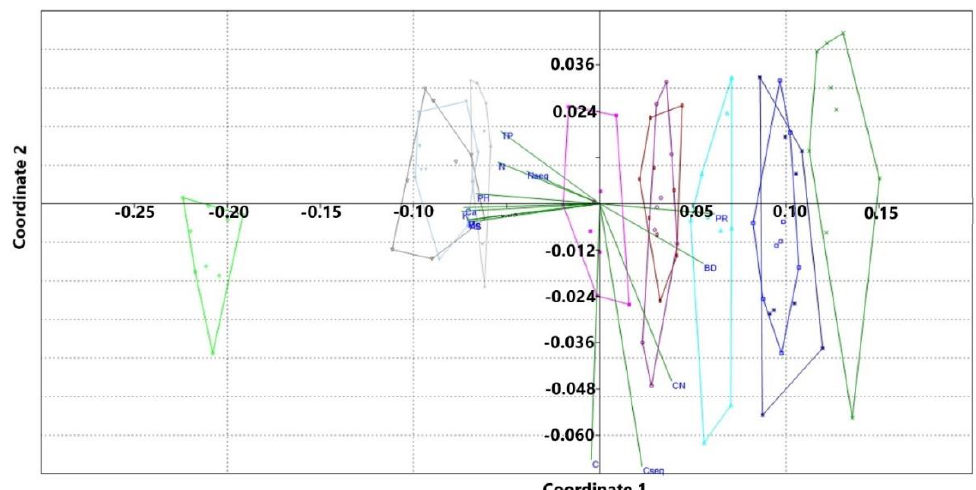
Figure 2. nMDS analysis of different soil physical properties in different mulching or no-mulching treatments for the soil layer 0–5 cm. UND, undisturbed (control), light green polygon; LM6.2, litter mulch level of 6.2 Mg ha − 1 , light grey polygon; LM12.2, litter mulch level of 12.2 Mg ha − 1 , dark grey polygon; LM18.6, litter mulch level of 18.6 Mg ha − 1 , light blue polygon; SM3.8, straw mulch level of 3.8 Mg ha − 1 , light purple polygon; SM7.6, straw mulch level of 7.6 Mg ha − 1 , dark purple polygon; SM11.4, straw mulch level of 11.4 Mg ha − 1 , red polygon; SDM11.1, sawdust mulch level of 11.1 Mg ha − 1 , bright light blue polygon; SDM22.2, sawdust mulch level of 22.2 Mg ha − 1 , blue polygon; SDM33.3, sawdust mulch level of 33.3 Mg ha − 1 , dark blue polygon; UNT, untreated treatment, dark green polygon. Table 4. Pearson correlation coefficient ( r value) between soil physical and chemical properties. BD = Bulk density (g cm −3 ), TP = Total porosity (%), PR = Penetration resistance (MPa), AS = Aggregate stability (%), Clay (%), Silt (%), Sand (%), pH = pH (1:2.5 H 2 O), C = C (%), N = N (%), C/N = C/N Soil, Cs = C storage (Mg ha −1 ), Ns = N storage (Mg ha −1 ), P = P (mg kg −1 ), K = K (mg kg −1 ), Ca = Ca (mg kg −1 ), Mg = Mg (mg kg −1 ). Note: * P < 0.05; ** P < 0.01.